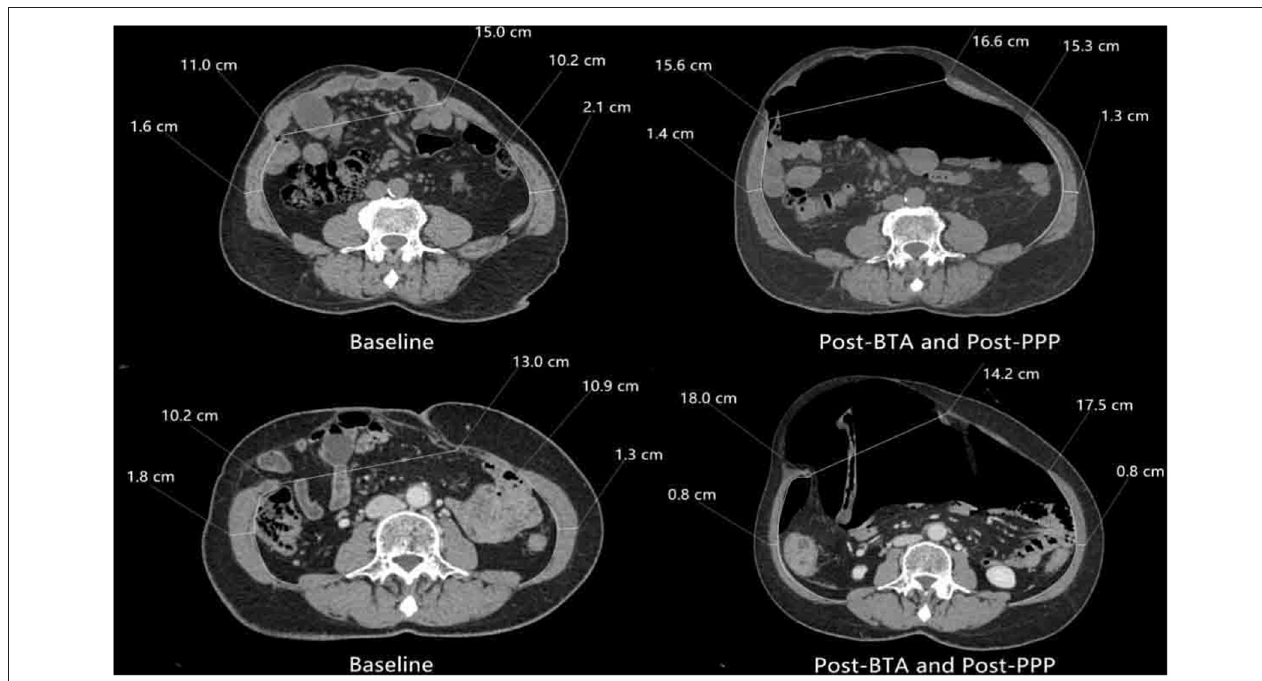
FIGURE 3 | Comparison of preoperative axial computed tomography image before and after preoperative techniques. There is significant elongation and thinning of the lateral abdominal oblique muscles.